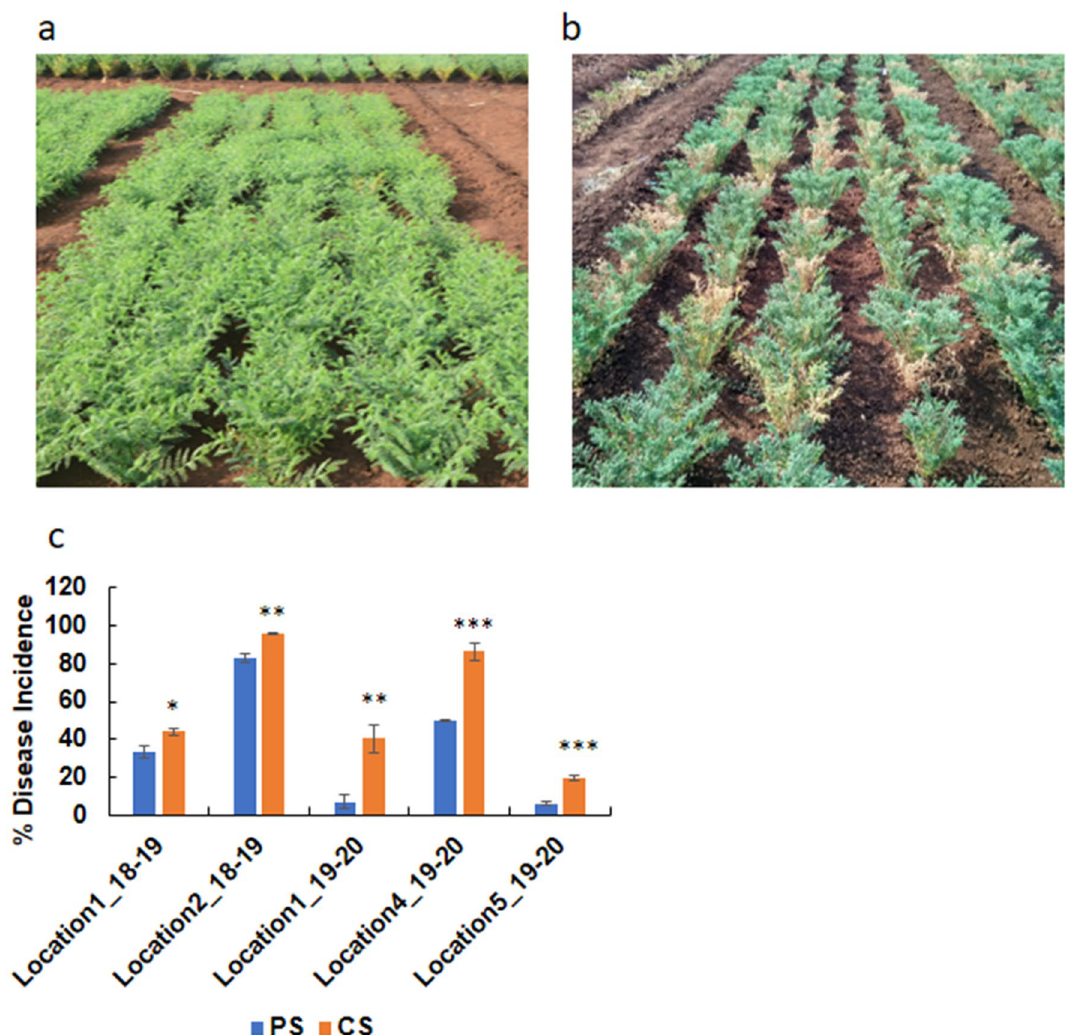
Figure 4. Dry root rot disease incidence under pathogen, and combined stress treatments in field trials. Field experiment was conducted at three different geographical locations during 2018–2019 and seven different geographical locations during 2019–2020 in India (Supplementary Fig. S5) with control, PS, LSM, and CS (Supplementary Fig. S6). The experiment was conducted with four replicates in RCB design. The results from PS and CS treatments were analysed to understand the impact of low soil moisture on DRR incidence. The field trial layout (representative) for PS treatment and CS treatment are shown in figure ( a ) and ( b ), respectively. Percent DRR disease incidence calculated during the field trial period are shown for five field trial location in the graph ( c ). All the DRR disease incidence is an average of three to four RCB replicates with Standard error of mean. Significance difference between means were analysed by Student’s t test . * p < 0.05, ** p < 0.005, *** p < 000.5. PS, pathogen stress; CS, combined low soil moisture and pathogen level by increasing evapotranspiration. Alternatively, high temperature may activate the pathogen in the soil, which otherwise is in the dormant phase for long period of time 33 . Further studies are required to understand this mechanism. Similar to the correlation results, ANN training with a combination of total rainfall from November to January and the average maximum temperature of October and November resulted in the best-fit model with high prediction accuracy. Also, similar to correlation analysis, ANN trained with the combination of total rainfall from November to January, and the average maximum temperature of February showed a high prediction accuracy. Both correlation and ANN training indicated a strong influence of the combination of the maximum temperatures for October and February with total rainfall from November to January in influencing DRR disease incidence. A plethora of studies have examined plant–pathogen–water interactions. Usually, high moisture supports foliar disease development, while the influence of water in root disease varies with the pathogen and plant type 1,34 . R. bataticola infection and DRR disease development in chickpea have been reported to increase under low soil moisture 5,8,12,35 . However, the exact mechanism for the same has not been deciphered yet. Besides low soil moisture, many other environmental and edaphic factors interact with the plant and pathogen during DRR disease development, but their direct or indirect role in disease development or water deficit stress imposition